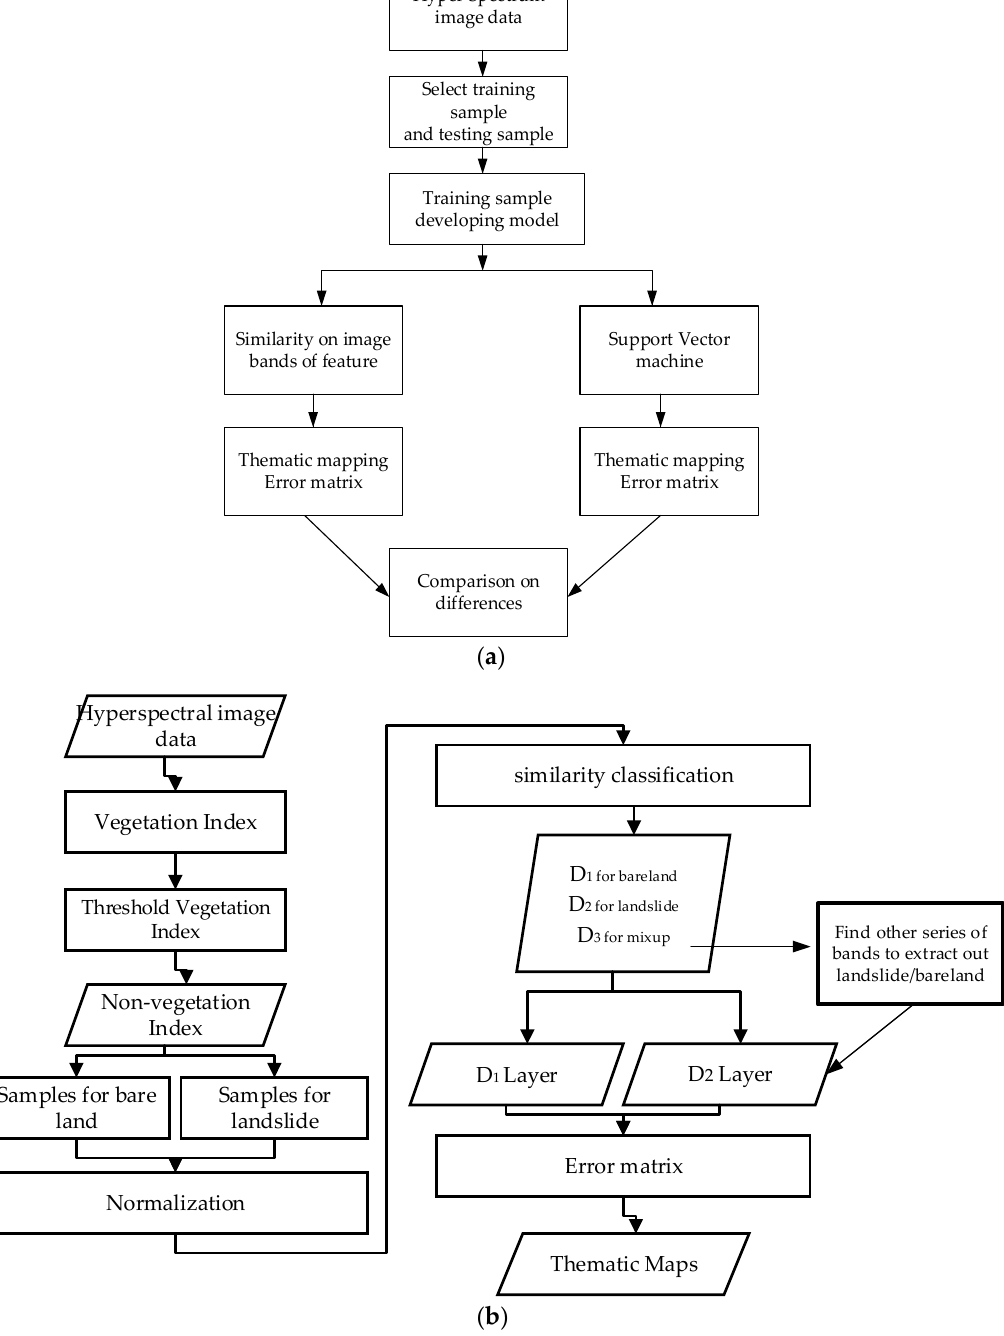
Figure 4. ( a ) research steps; ( b ) the steps for similarity classification.